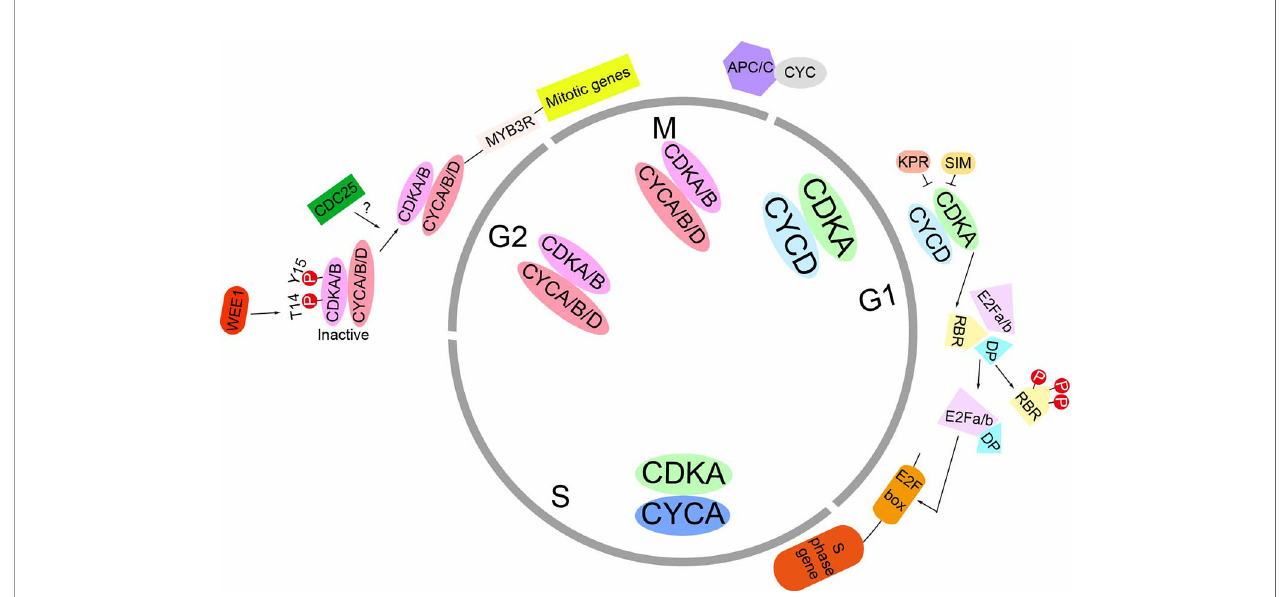
FIGURE 1 | Schematic representation of the mitotic cell cycle in plants. At the G1 phase, D-type cyclins (CYCD) interact with the A-type CDK (CDKA), forming the CDKA/CYCD complex. The activity of CDKA/CYCD complex can be negatively regulated by KPR and SIM proteins. Once activation, this complex phosphorylates RBR to release the transcript factor E2Fa/b-DP. This E2Fa/b-DP complex binds to the E2F box and activate the transcription of S phase genes. At the G2 and M phase S, CYCA and CYCB are strongly expressed and their gene products assemble with CDKA and CDKB. The CYCD can also associate with CDKs. At the beginning of G2 phase, CDK activity are inhibited because of the phosphorylation of Y14 and T15 site by WEEI kinase. The CDC25-related kinase, which removes the inhibitory phosphate groups, still needs to be identi fi ed. Once the CDK/CYC complex are active, they phosphorylate MYB3R transcription factors and activate mitotic genes ’ transcription. Mitotic exit requires anaphase-promoting complex (APC), which degrades cyclins through ubiquitin-proteasome